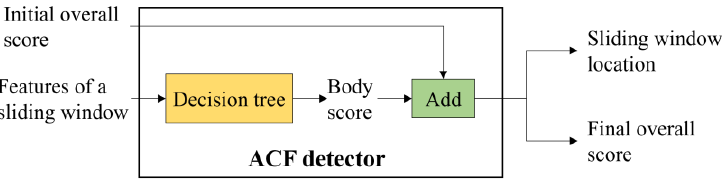
Figure 16. Diagram of the ACF detector.